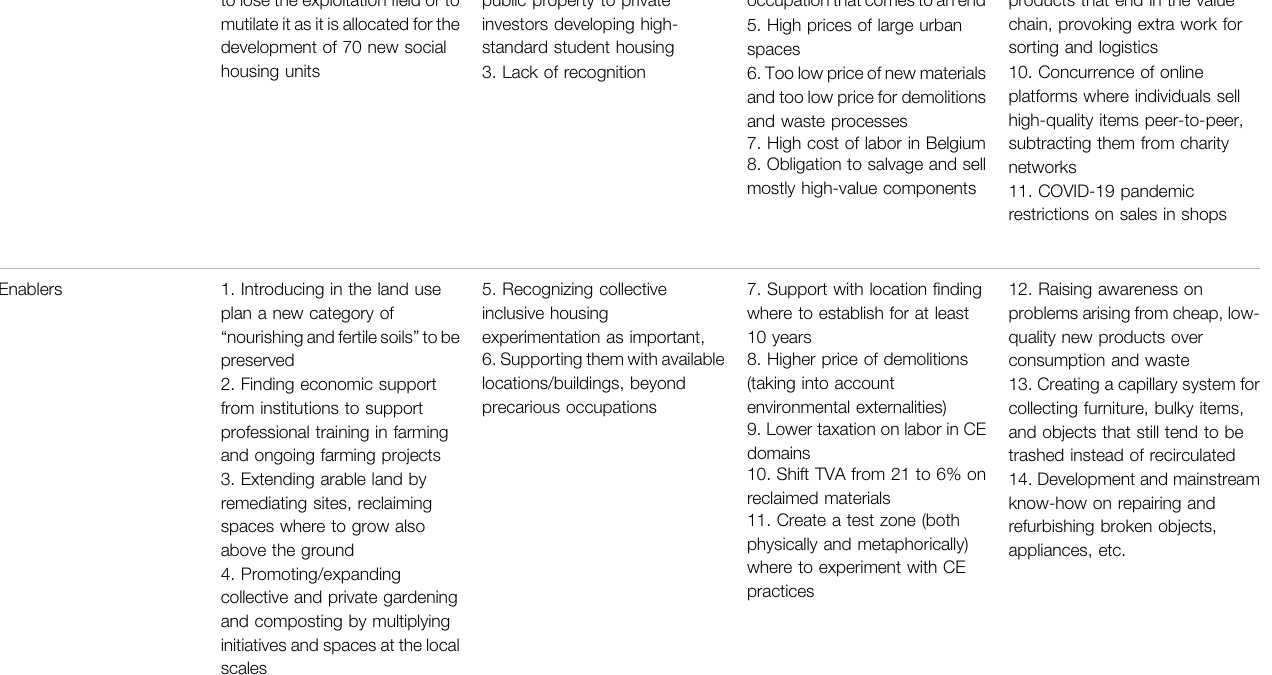
Urban circularity Aim #1: Reduce footprints (narrow/ slow/close material